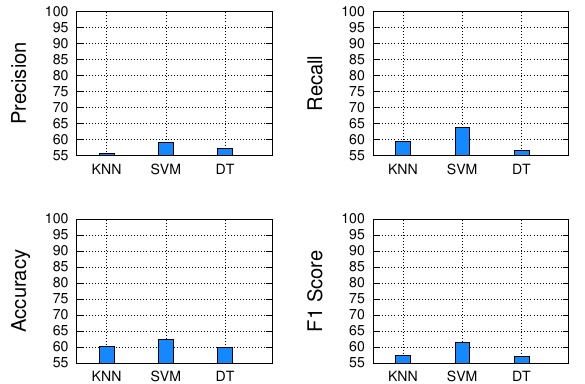
Figure 5. Performance measures for the Zeus DDoS malware family with network artifact classification using Chatter atop a baseline